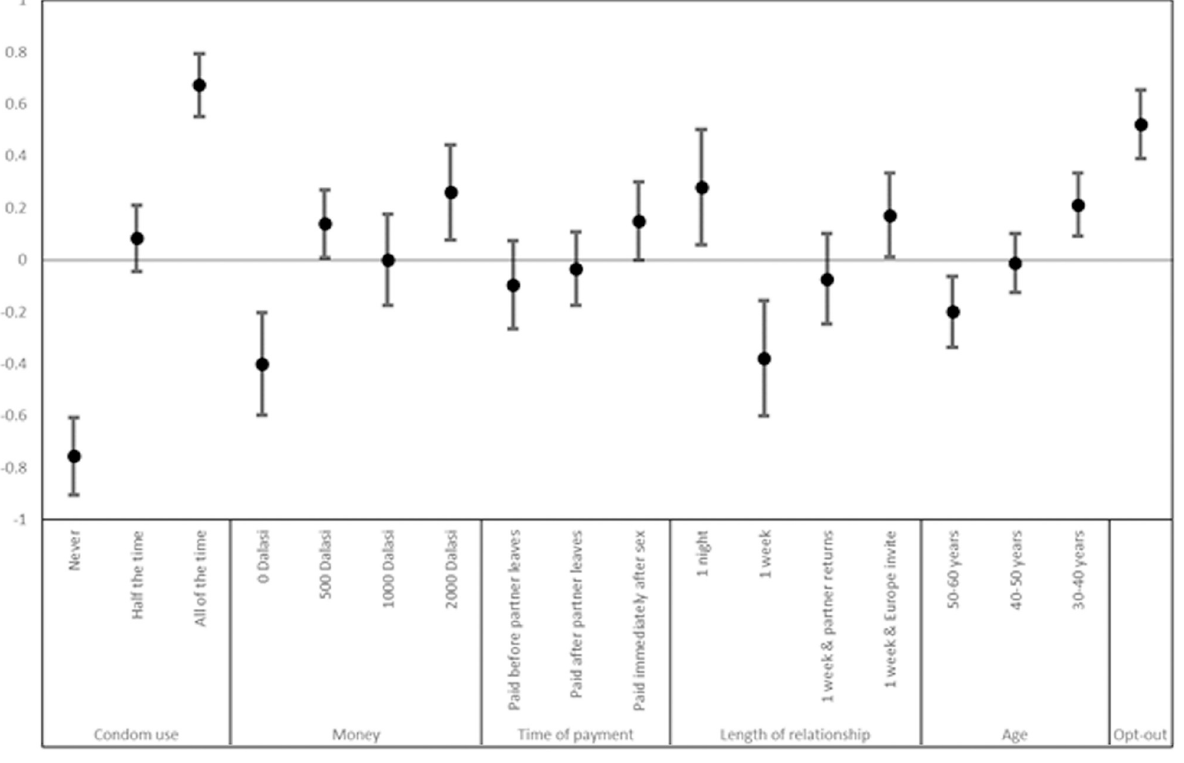
Fig 4. DCE results—Effects coded multinomial logit